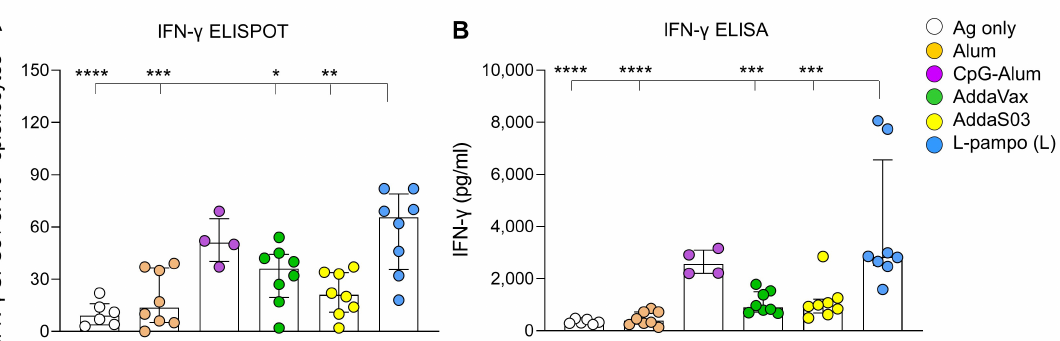
Figure 4. RBD-Fc antigen with L-pampo induces cell-mediated responses. ( A , B ) BALB/c mice (total n = 42; n = 6/antigen- only; n = 8/Alum, AddaVax, AddaS03, or L-pampo (L); n = 4/CpG–Alum) were immunized with RBD-Fc with or without adjuvants i.m. on day 0 and day 21 as described in Figure 3A. On day 35, splenocytes were stimulated with the PepMix TM SARS-CoV-2(S-RBD) peptide pool, and RBD-specific IFN- γ secreting cells were analyzed as SFCs by ELISPOT assay ( A ) or total IFN-γ production by ELISA assay ( B ). Data shown are median ± IQR. Each dot represents an individual mouse. Data reflect 2 independent experiments (n = 3/antigen-only group; n = 4/Alum, AddaVax, AddaS03, or L-pampo(L) group; n = 2/CpG–Alum group in single experiment). Asterisks indicate statistically significant differences in comparison to the L-pampo (L) group. * p < 0.05; ** p < 0.01; *** p < 0.001; **** p < 0.0001; one way ANOVA with the Tukey’s test.